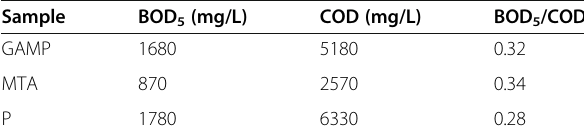
Table 5 Biochemical oxygen demand (BOD 5 ) and Chemical oxygen demand (COD) of the wastewater after retanning